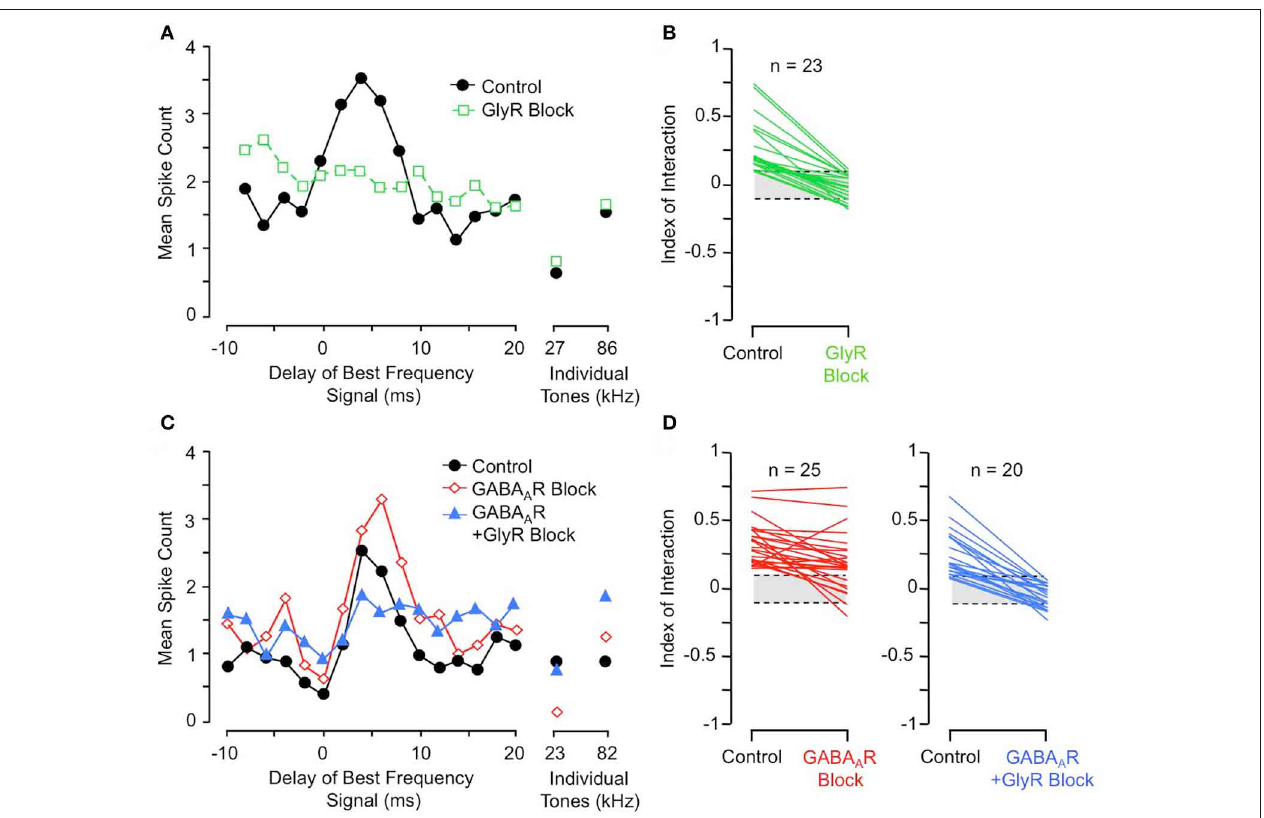
FIGURE 9 | Glycine receptor blockade eliminates combination-sensitive facilitation in IC neurons. (A) In IC neuron, blockade of GlyRs eliminates 27kHz facilitation of 86kHz ChF response. (B) Effects of GlyR blockade on low-frequency facilitation among IC neurons. In all neurons, GlyR blockade eliminated or greatly reduced combination-sensitive facilitation. (C) In an IC